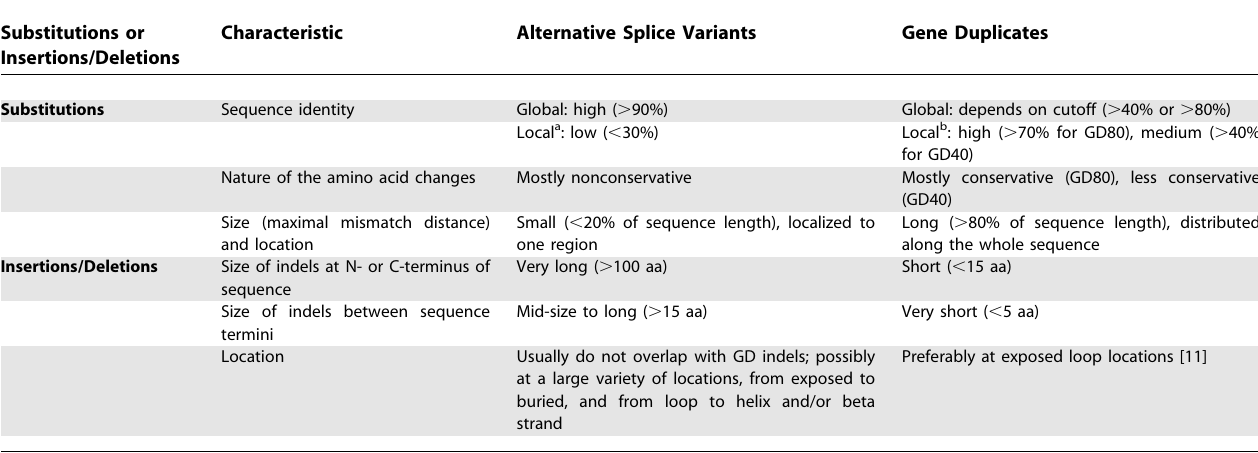
Table 1. Summary of the Effects of Alternative Splicing and Gene Duplication on Sequence and Structure Substitutions or